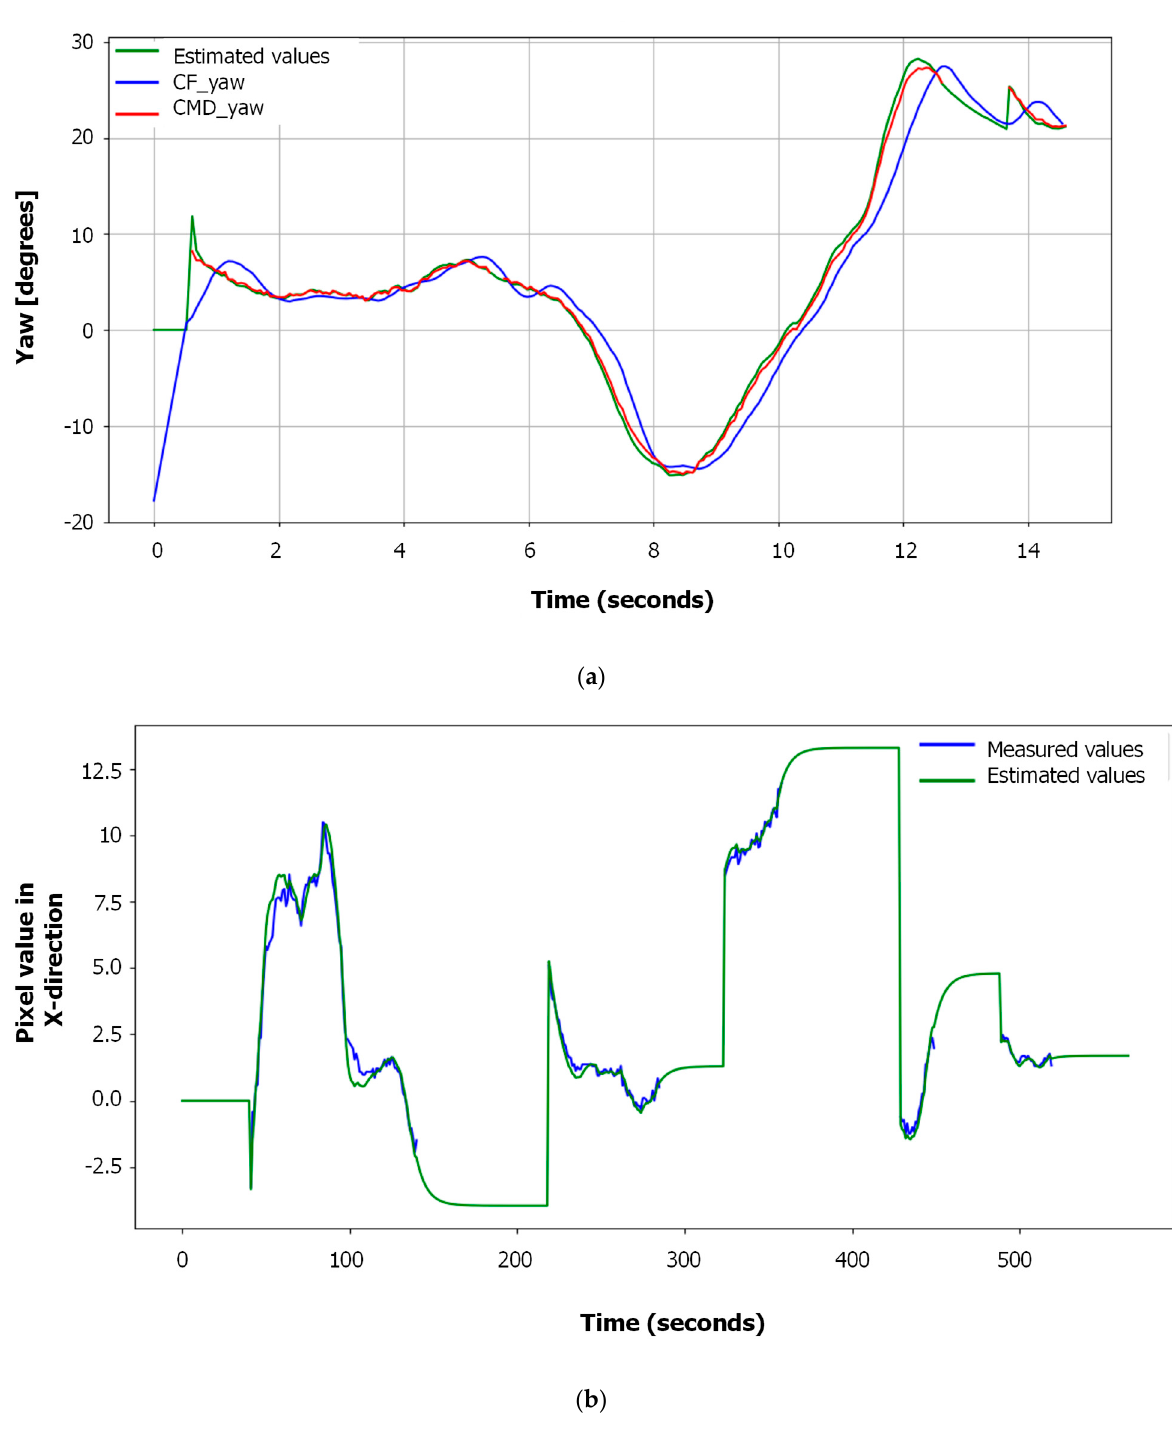
Figure 5. Experimental results: ( a ) estimation along the yaw; ( b ) estimation of marker center along the x-direction. Similarly, in Figure 5b the Kalman filter was used in an experiment for tracking the center point of the ArUco marker. In this experiment, the camera view was obstructed at different points in time and moved to a new location. The filter was limited to output only an estimate for a maximum of 25 frames in a row when the marker was not detected and data were sampled only when the marker was detected or estimated by the Kalman filter; hence, the peaks in a green line. Similar to the plot in Figure 5a, the factor α = 0:85 was set for diminishing the velocity ˆ v k = α ˆ v k − 1 for each iteration where an estimation was made in the previous time step for a maximum n max number of